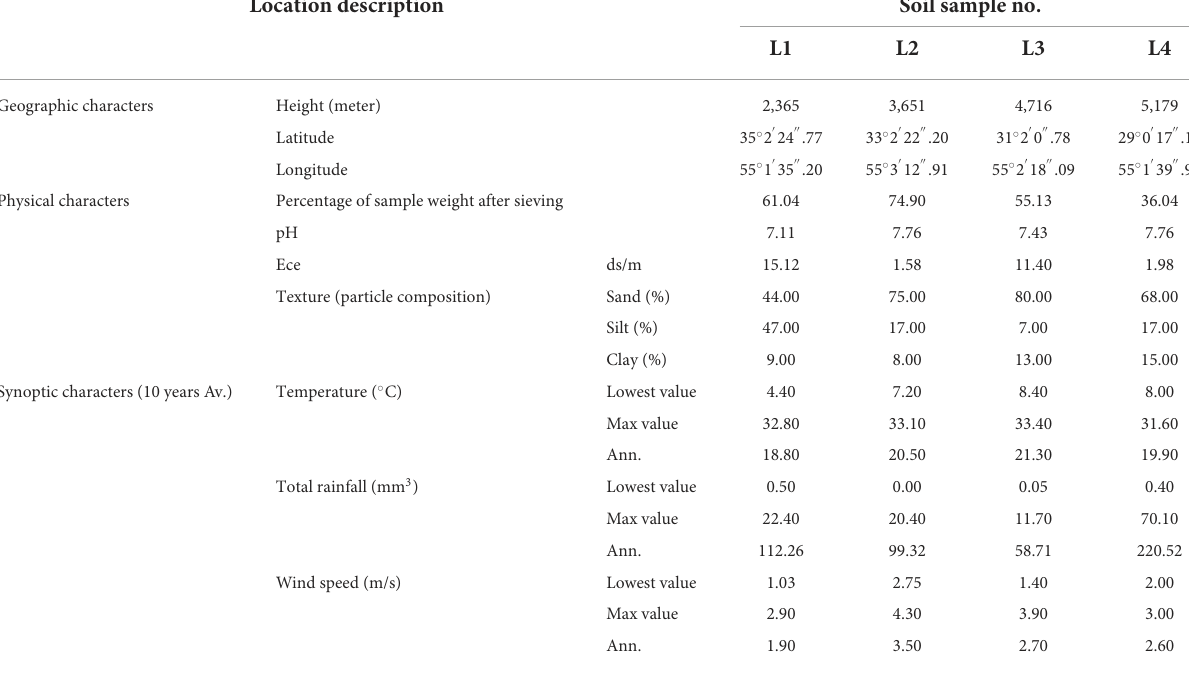
TABLE 1 Selected geographic and eco-physiological characters of soil samples along the elevational gradient from 2009 to